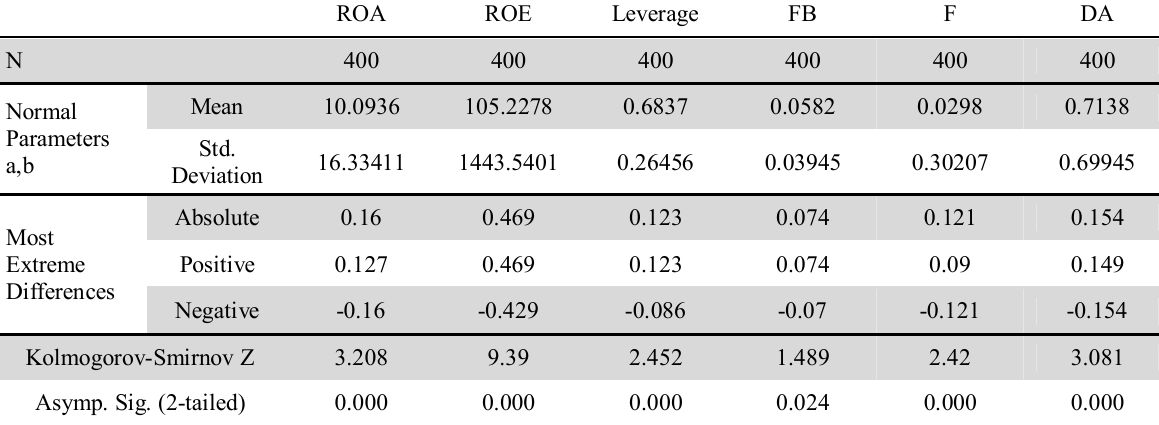
The summary of One-Sample Kolmogorov-Smirnov Test